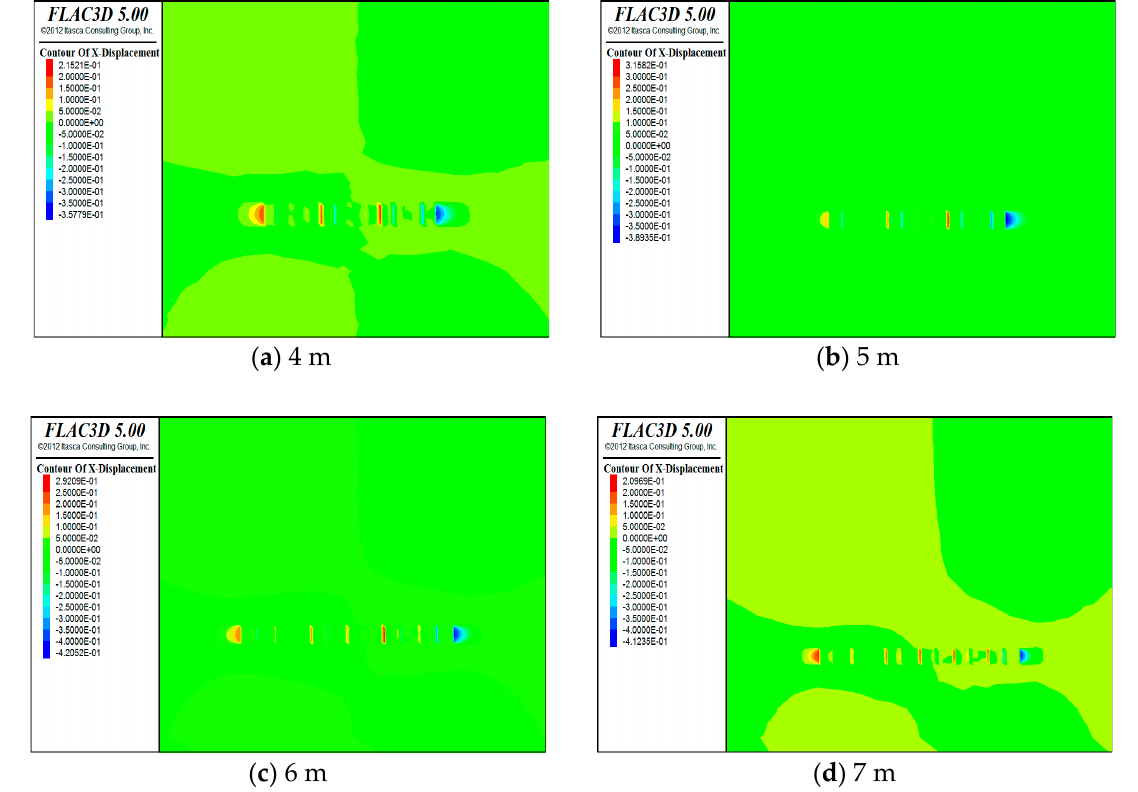
Figure 11. Horizontal displacement cloud for ( a ) 4 m, ( b ) 5 m, ( c ) 6 m, and ( d ) 7 m.